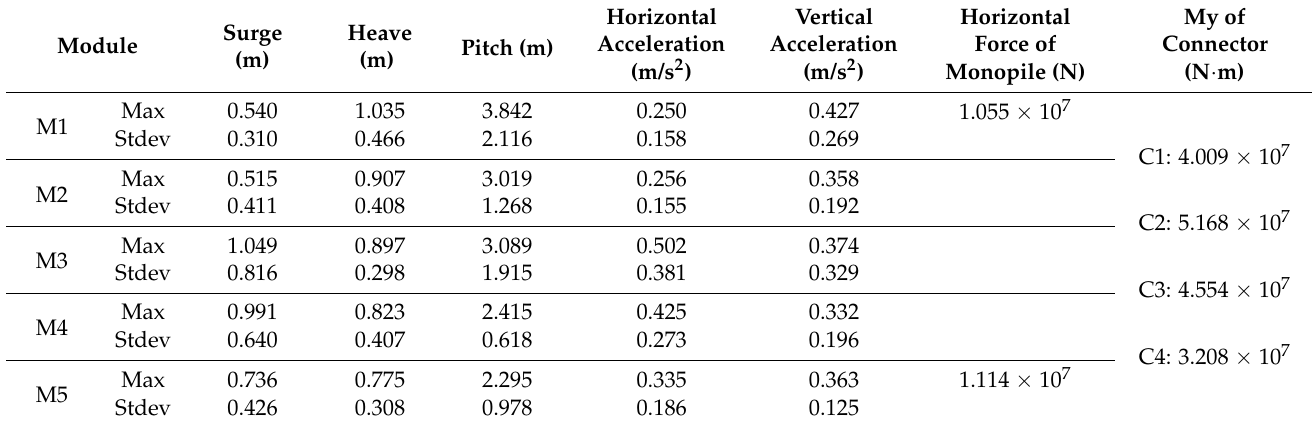
Table 5. Statistic information of extreme responses of the MIFS system with releasing